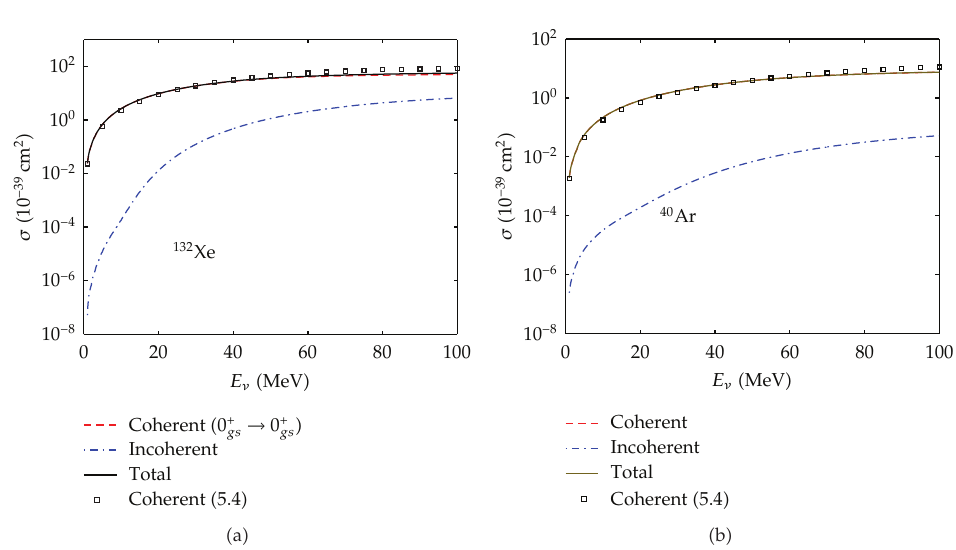
Figure 4: (cid:3) Color on line (cid:4) . Coherent, incoherent, and total cross section as a function of the incoming neutrino energy E ν , in the NC reactions 132 Xe (cid:3) ν,ν (cid:4) (cid:4) 132 Xe (cid:3) a (cid:4) and 40 Ar (cid:3) ν,ν (cid:4) (cid:4) 40 Ar (cid:3) b (cid:4)